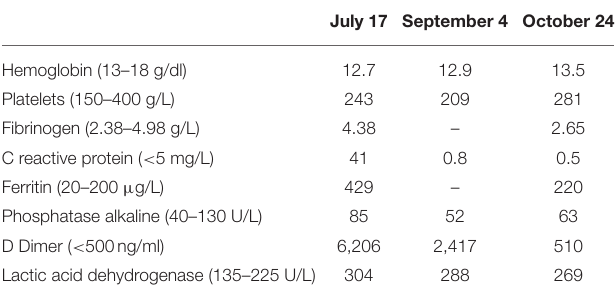
TABLE 3 | Blood analyses that gradually improved and returned to normal by the end of October